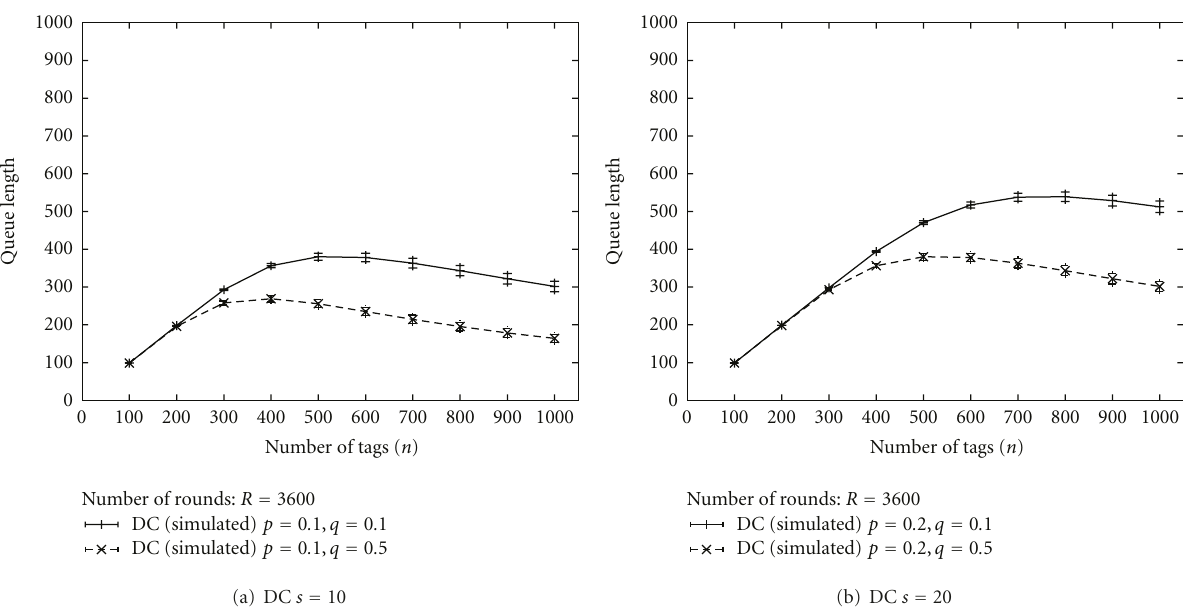
Figure 6: Dynamic counter (DC), experiments to show the impact of parameter n on tag’s queue length. Average value and standard